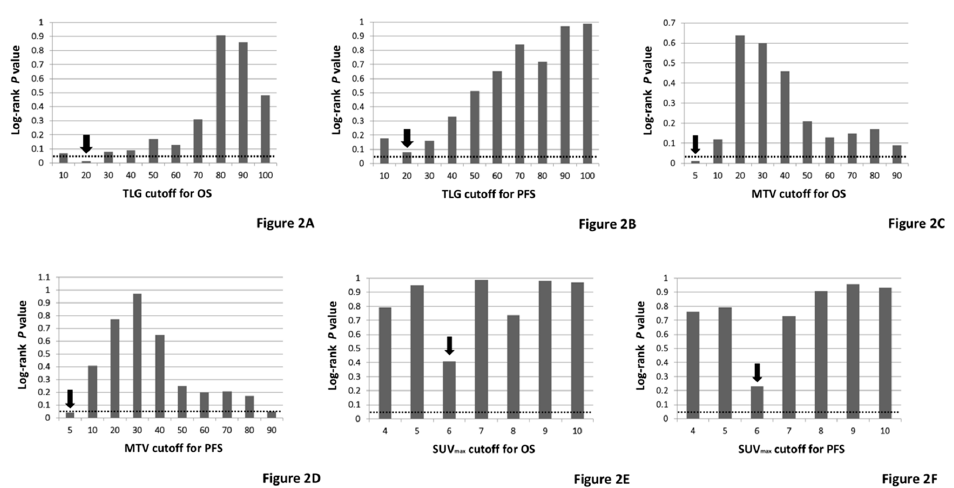
Figure 2. Discriminative value by log-rank test according to various TLG ( A ), MTV ( C ) and SUVmax ( E ) cutoff for OS and TLG ( B ), MTV ( D ) and SUVmax ( F ) cutoff for PFS in 18F-FDG-PET.